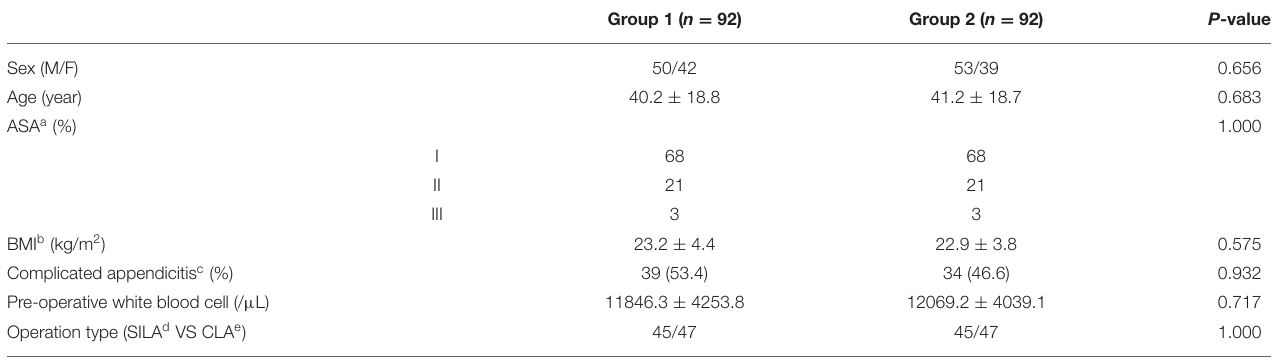
TABLE 1 | Patient characteristics.